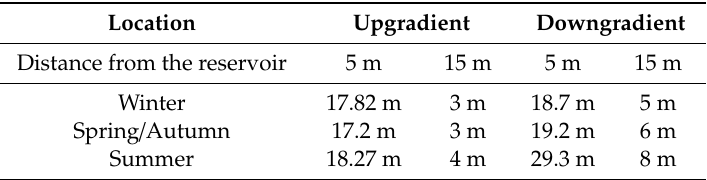
Table1. Differencebetweenmaximumandminimumpiezometricheadsduringthewinter,spring / autumn and summer periods considering the F-CI